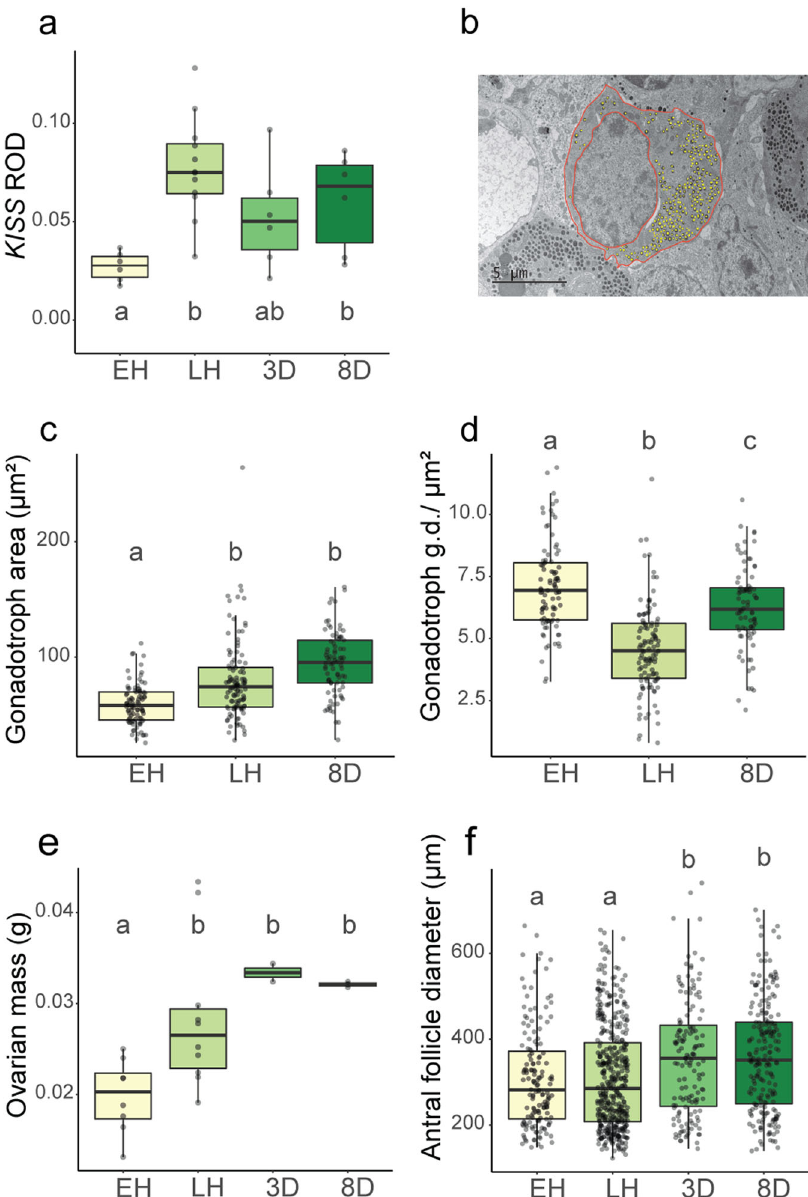
Fig. 4 Activation of reproductive axis during hibernation in female arctic ground squirrels. a Kisspeptin expression in the arcuate nucleus as quanti fi ed by in-situ hybridization (ROD = relative optical density). b Electron microscopy image of gonadotrophs with secretory granules in false yellow coloring and cell and nucleus outlined in false pink coloring. c Cell area and d secretory granule density (g.d.) of gonadotrophs (granules/ μ m 2 ) in the anterior pituitary. e Mass of frozen ovaries and f diameter of antral follicles. In all graphs, colored shading of box-plots represents distinct sampling groups, lower-case letters indicate signi fi cantly different comparisons from data analyzed with a linear mixed effects model ( p < 0.05), the center line in the box plot represents the median, box boundaries represent the 25th and 75th percentiles, and error bars of boxplots represent the 25th and 75th percentiles ± 1.5 times the interquartile range. For sample sizes, see “ Methods ” . See also Supplementary Fig.